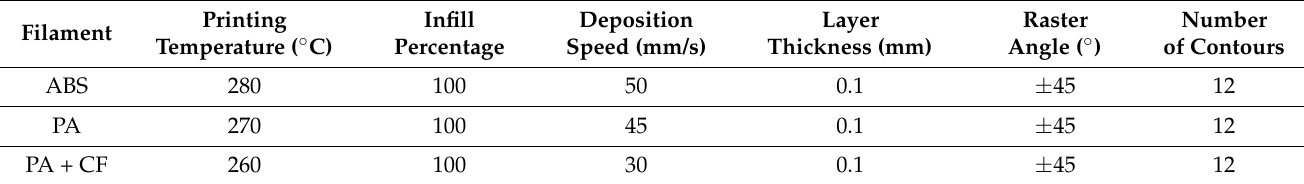
Table 1. 3D printed parameters for each